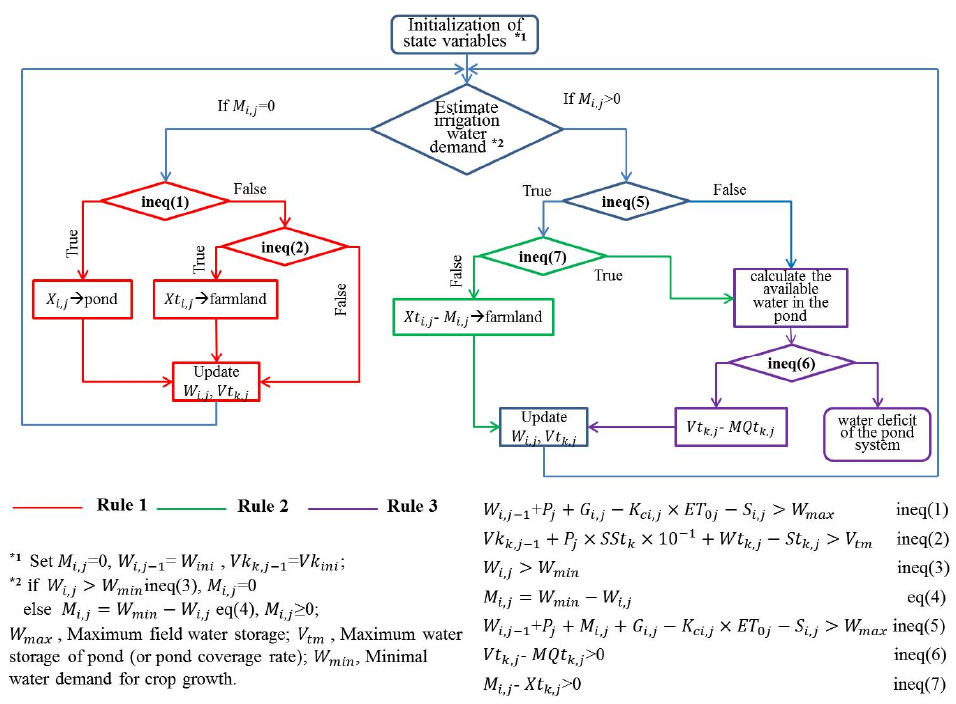
Figure 4. Simulation flow chart of a basic calculation unit.